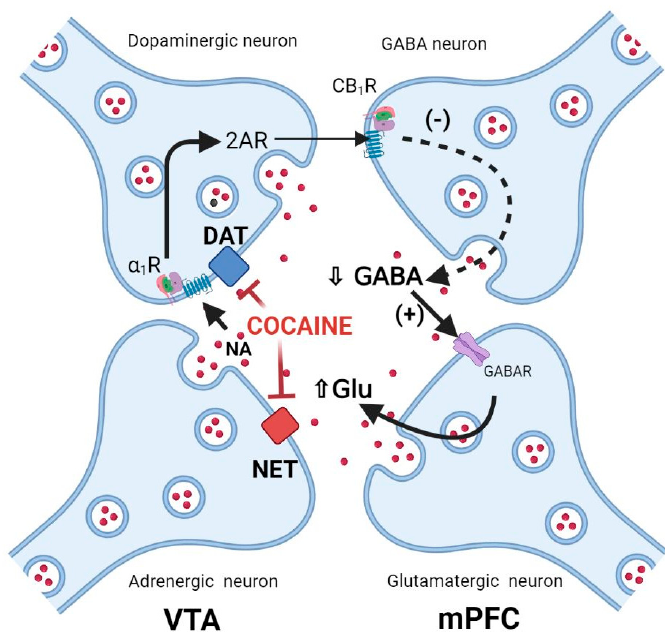
Figure 4. The proposed mechanism for promoting glutamatergic neurotransmission by cocaine— cocaine inhibits the reuptake of dopamine (DA) and norepinephrine (NA) due to the inhibition of specific dopamine transporter (DAT) and norepinephrine (NET) transporters in medial prefrontal cortex (mPFC). NA in the synaptic cleft stimulates α 1 ( α 1 R) receptors in DA neurons by promoting the release of endocannabinoids (2-arachidonoylglycerol, 2AR) which, after binding to CB 1 R receptors, inhibit gamma-aminobutyric acid (GABA) release in the synaptic cleft. A lower concentration of GABA promotes the release of glutamate (GLU) due to the suppression of the inhibitory effect of GABA on the release of GLU. Created with BioRender.com (accessed on 22 January